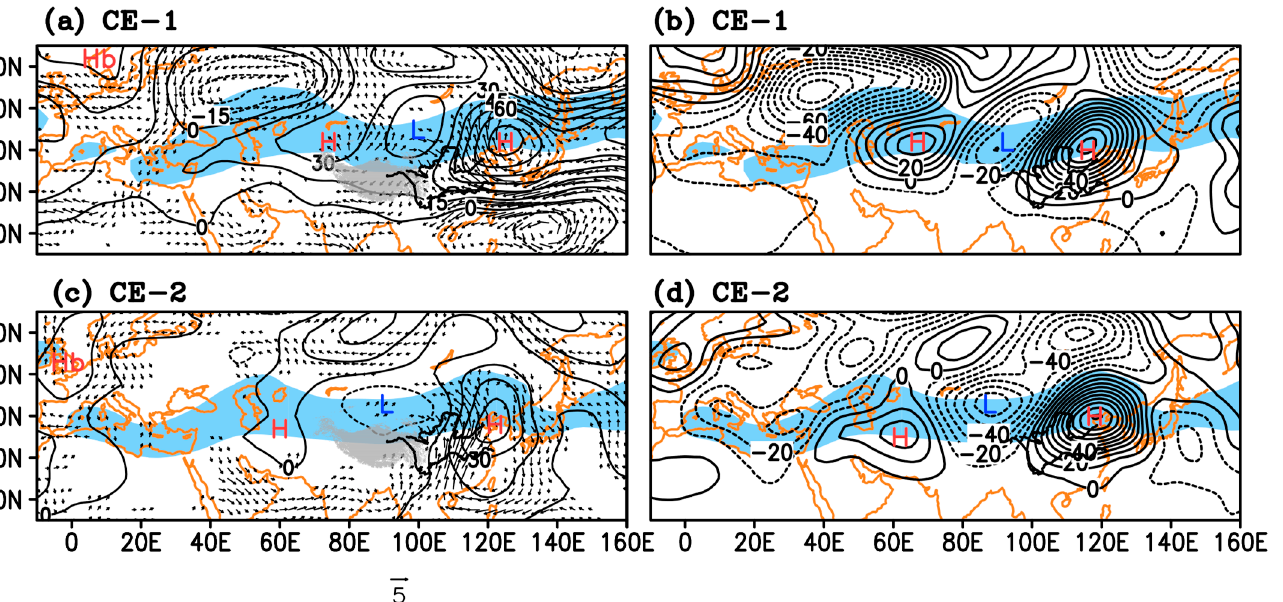
Figure 6. Composites of 500 hPa geopotential height anomalies (contour, units: gpm) and 850 hPa wind velocity (vector, unit: m·s − 1 ) ( a , c ) and of 300 hPa geopotential height anomalies ( b , d ) at Lag 0 days of the REP events in CE-1 ( a , b ) and CE-2 ( c , d ); the blue shaded regions indicate the zonal wind velocity (larger than 15 m/s) at 300 hPa, ‘Hb’ indicates the blocking high, and ‘H’ and ‘L’ indicate the high- and low-pressure anomalies, respectively. The clusters are based on all Lag 0 days of the REP events. The gray shaded areas in ( a , c ) indicate elevations > 3200